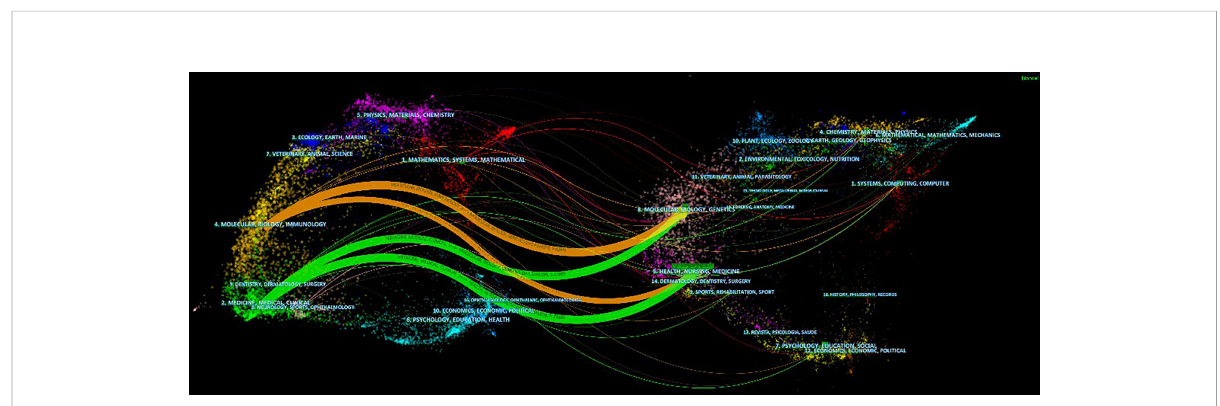
FIGURE 5 A dual-map overlay of journals related to AI on CRC.(Left) Citing journals. (Right) Cited journals. The color of the links distinguishes the discipline of the source.